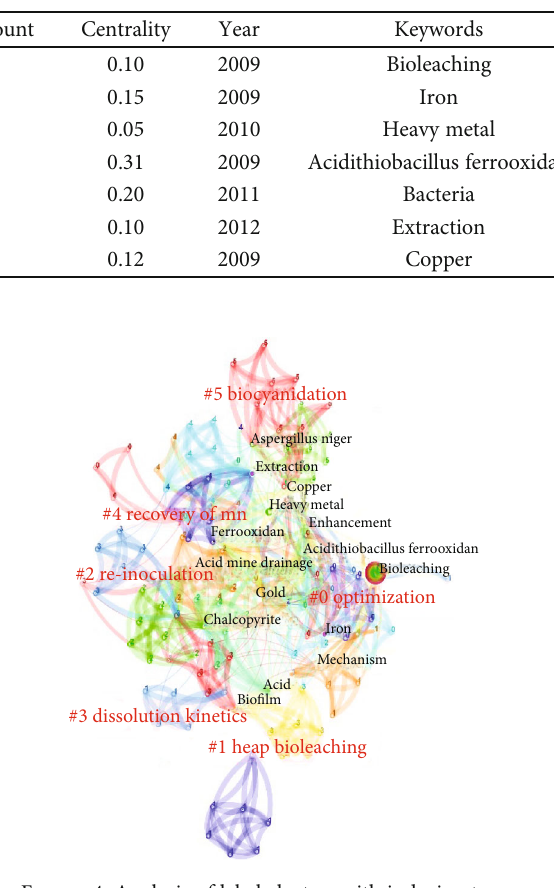
Table 3: Count, centrality, and earliest occurrence year of keywords.